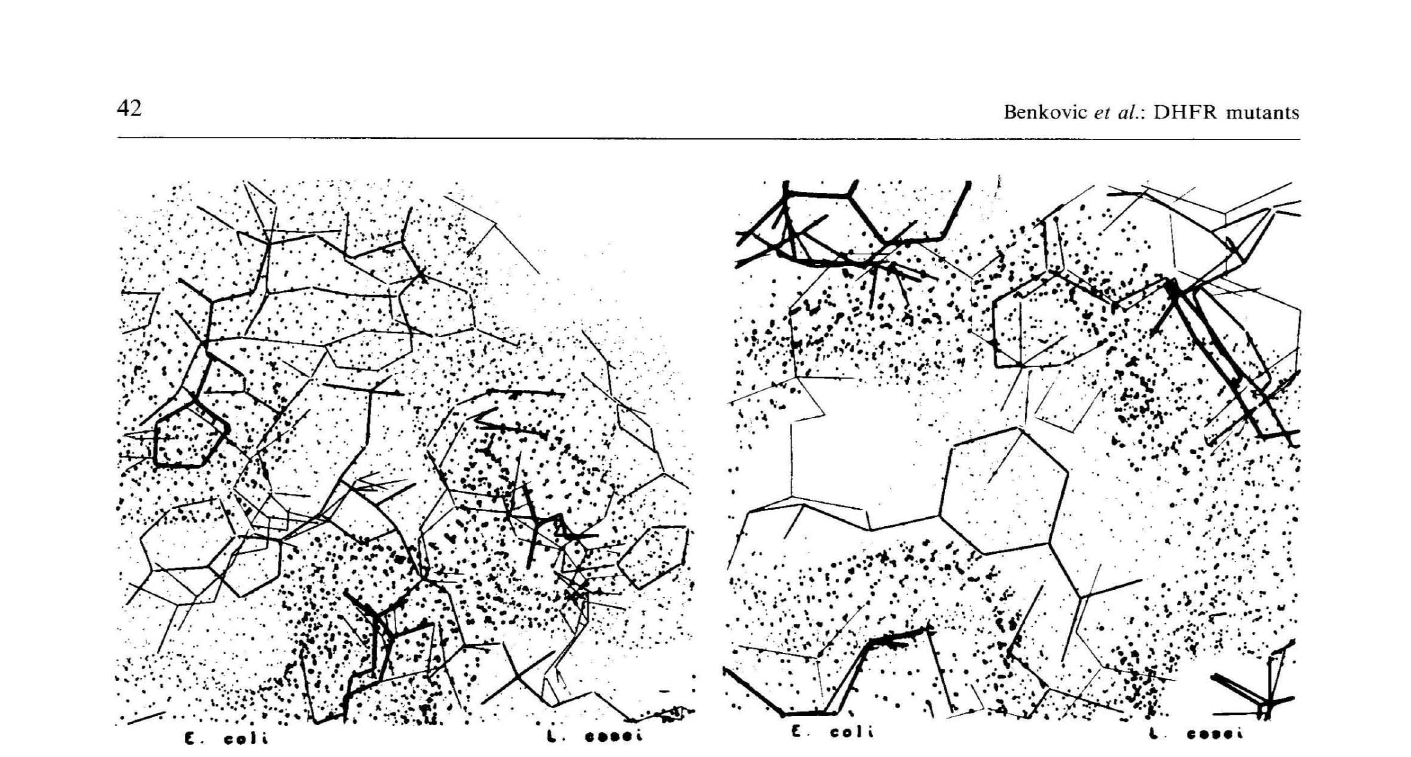
Figure 5. Superpositioning of the active sites of the E. coli and L. casei DHFRs with NADPH as a center for alignment. All residues within 7 A were included. Some key residues that are visible in the left hand panel (adenine portion) arc (E. coli: L. casei); Gln-65: Gln-65 (top); Arg-44: Arg-43 (middle right); Arg-98: Gln-lOl (bottom); and Ser-64: His-64 (middle left). In the right hand panel (nicotinamide portion) the key residues are (E. coli : L. casei); Ile-94: Ala-97 (upper right); Phe-31 : Phe-30 (middle right); Asp-27 : Asp-26 (lower right); and Ile-50: Phe-29 (upper left). These residues are depicted using BlOG RAF*.